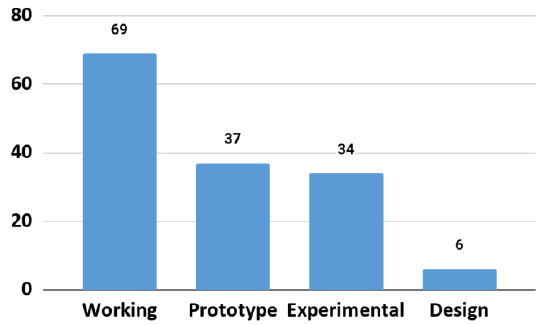
Figure 11. Distribution of solution types presented.